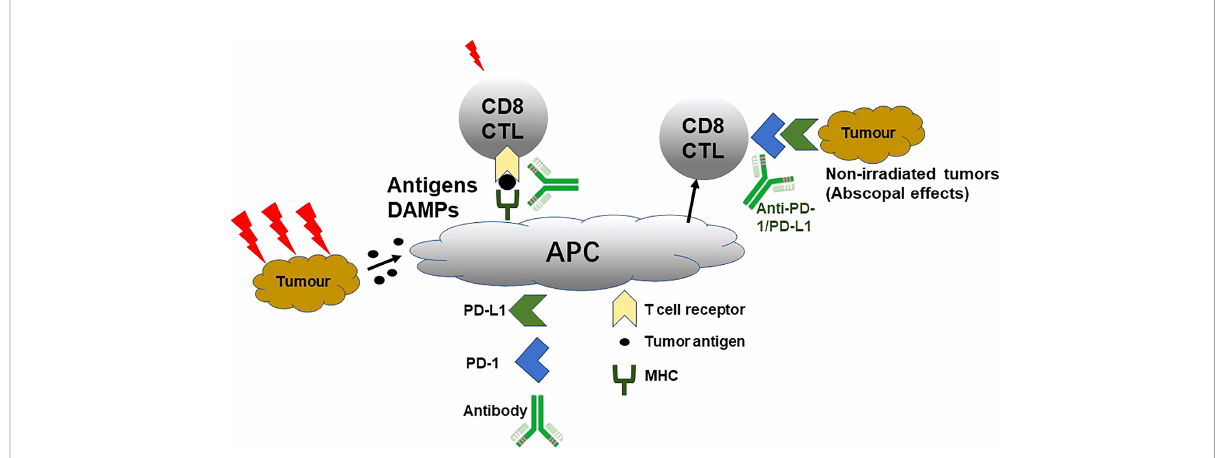
FIGURE 2 Schematic mechanism of radiotherapy enlarging anti-PD-1/PD-L1 curative effect. Damage-associated molecular patterns, cytotoxic T lymphocytes, antigen-presenting cell, and MHC. Reproduced with permission